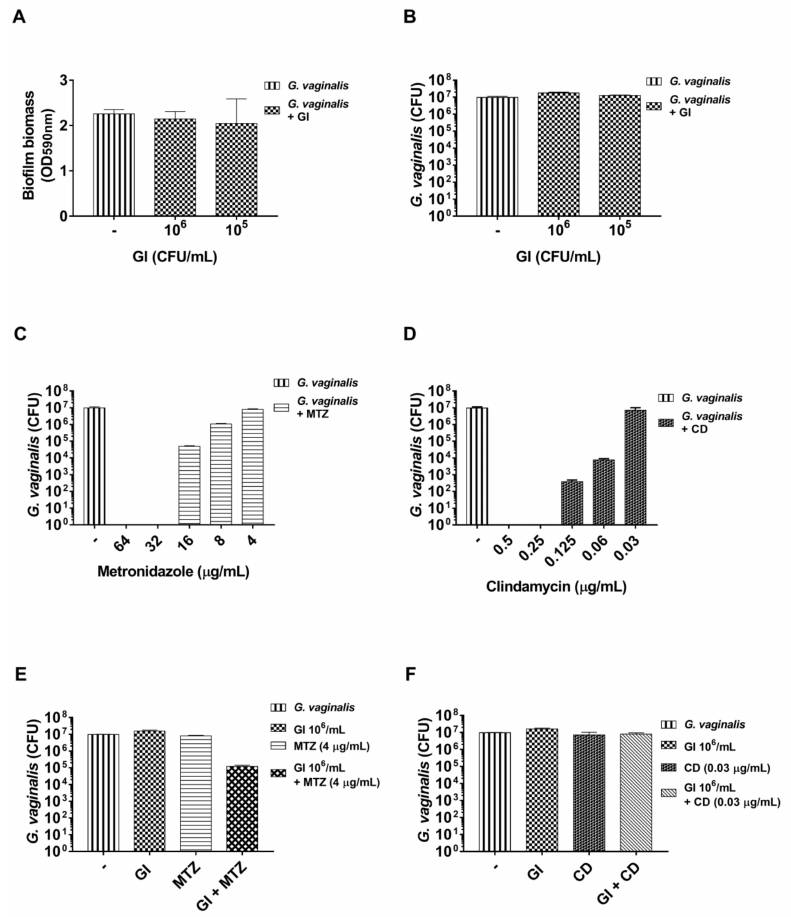
Figure 5. E ff ect of S. cerevisiae CNCM I-3856 (GI)-antibiotic combination on preformed G.